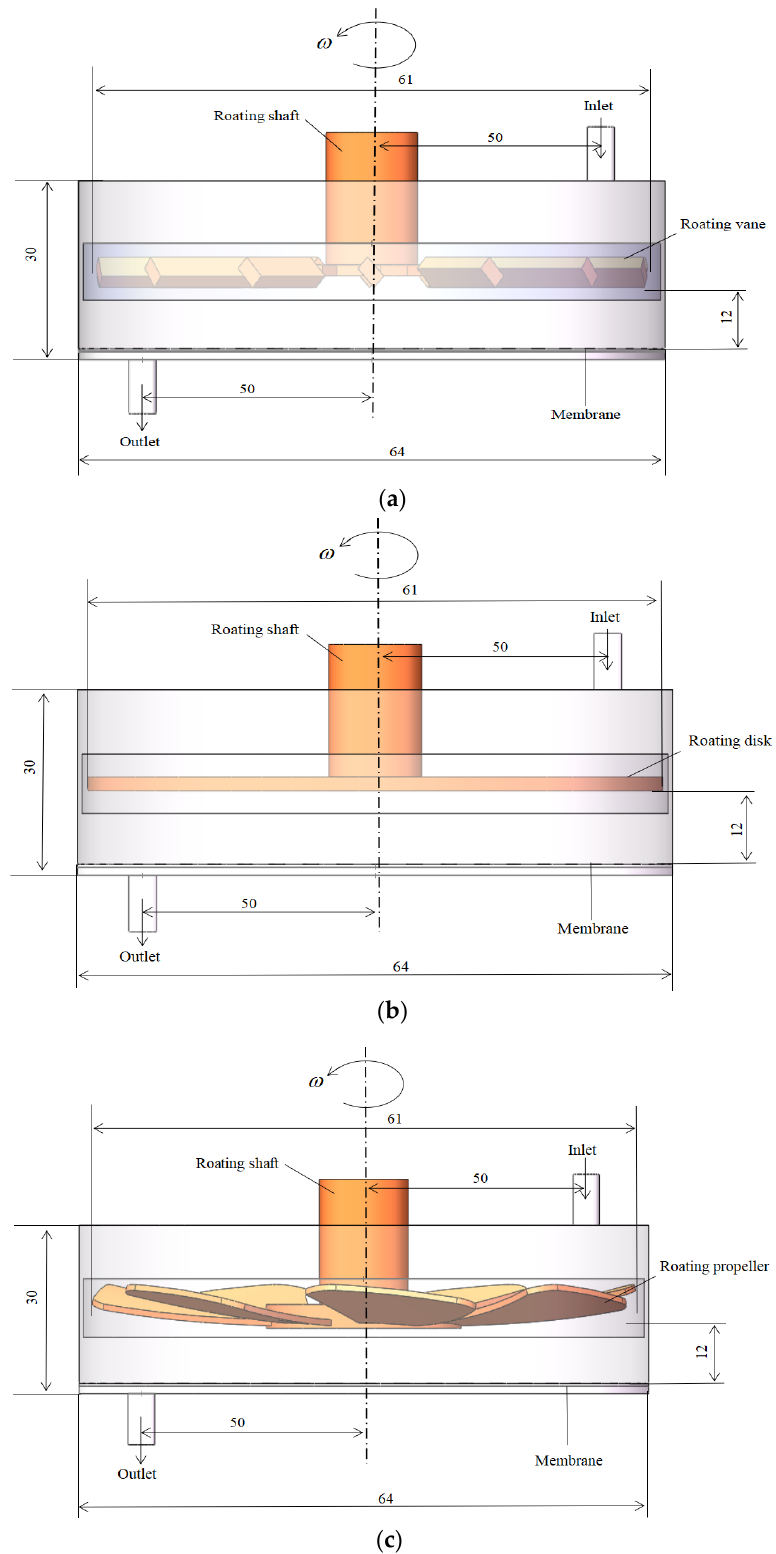
Figure 1. Numerical simulation model of three types of dynamic cross-flow filtration equipment.